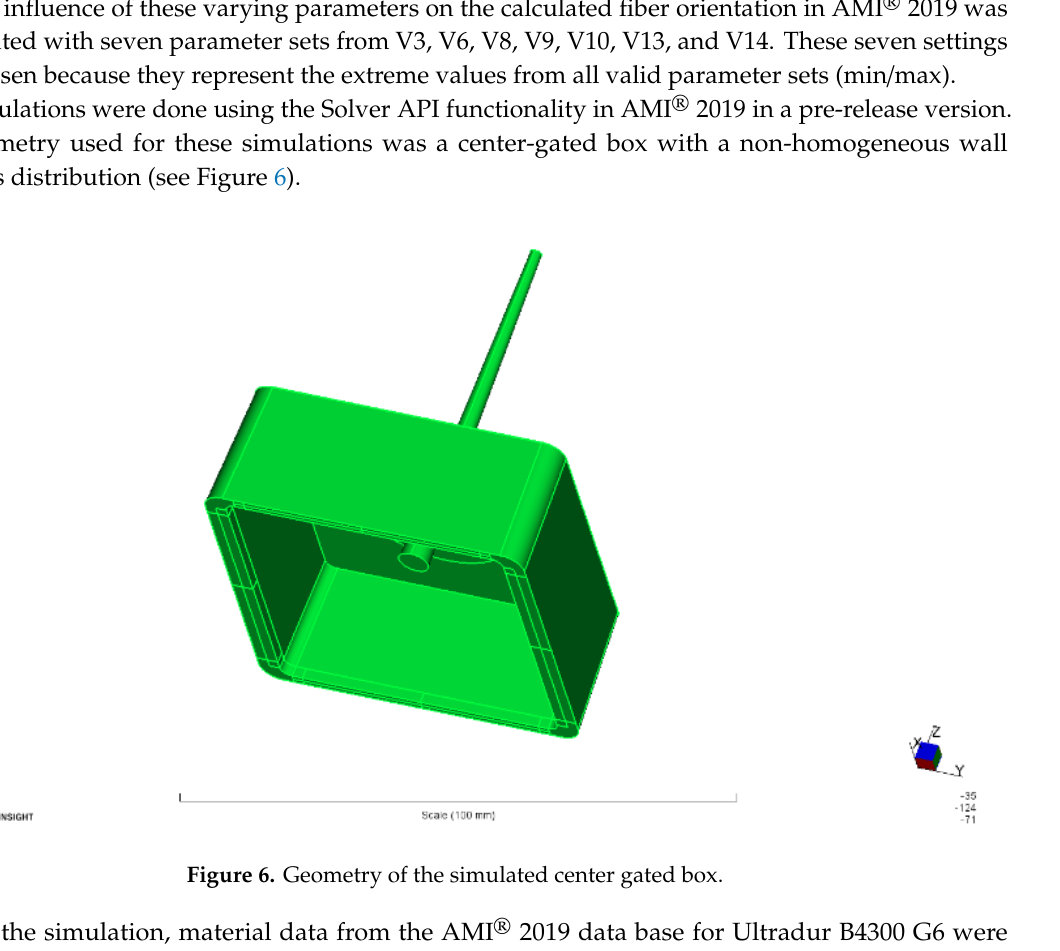
Figure 5. ( a ) Predicted Response Graph for R1 to R3 vs. F1 to F3. ( b ) Influence of factors on the response C I (top), D 2 (middle), and κ (bottom).